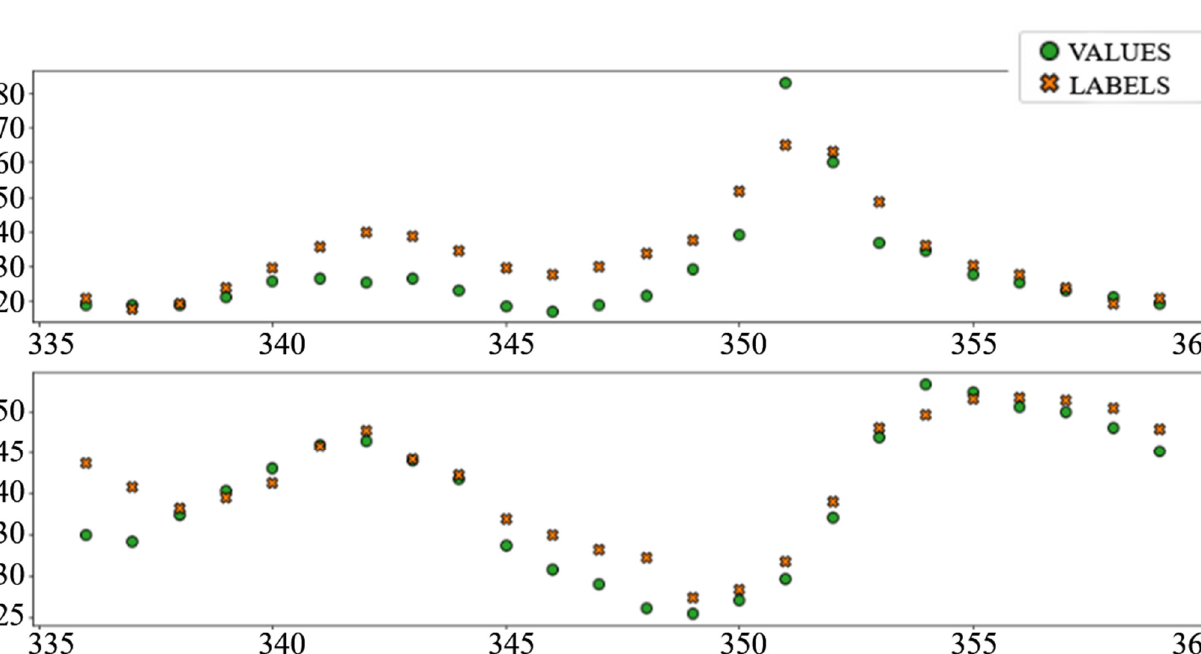
Figure 12. Price prediction examples: “TCN_Dense”.